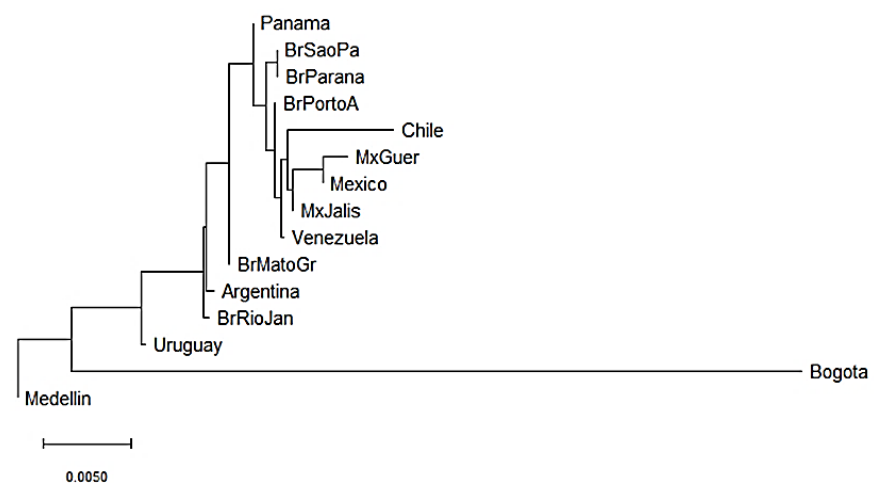
Figure 2. Neighbor-joining (NJ) dendrogram of Nei’s genetic distances among Central and South American populations, based on the KIR genes frequencies. The NJ dendrogram was constructed with 15 American populations from Brazil ( n = 1327), Mexico ( n = 544), Argentina ( n = 365), Venezuela ( n = 205), Panama ( n = 116), Chile ( n = 90), Uruguay ( n = 41), Bogota—Colombia ( n = 119) and Medellin—Colombia ( n = 161). The bar suggests a 0.005 (0.5%) KIR gene frequencies variation for the length of the scale.